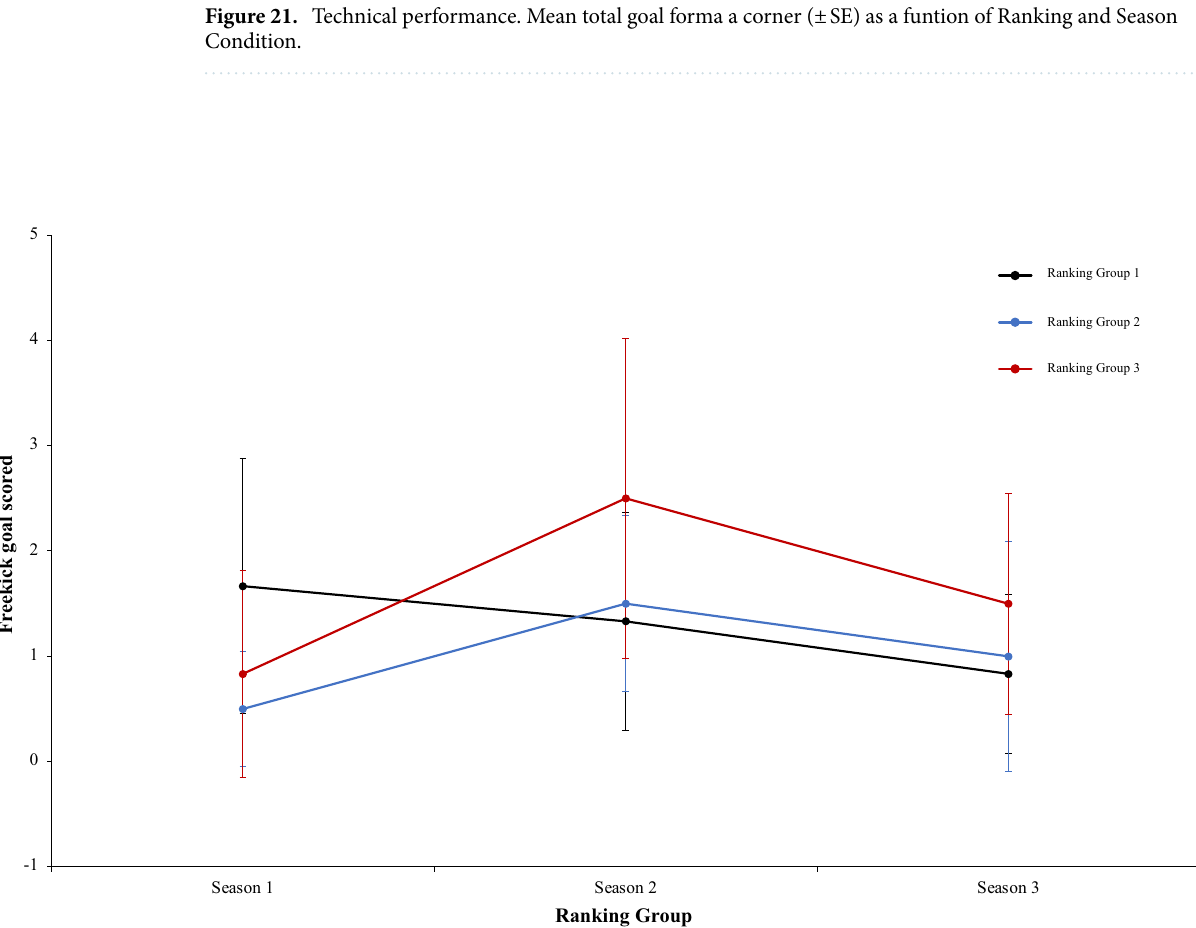
Figure 22. Technical performance. Mean freekick goal scored (± SE) as a funtion of Ranking and Ranking